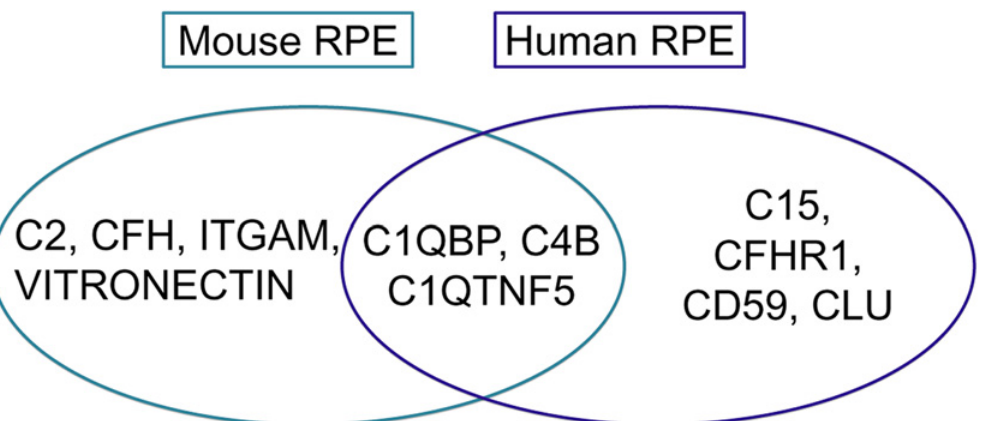
Fig 5. Overview of highly expressed complement factors in the human and mouse RPE. Complement factors in the overlay of the circles are highly expressed in RPE of both species.